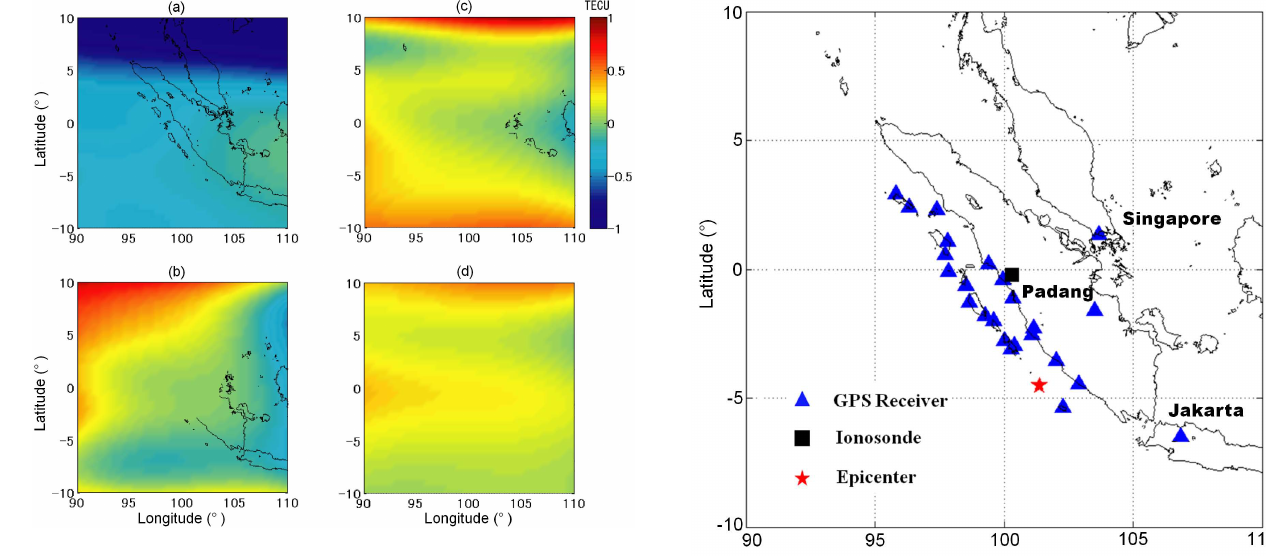
Fig. 3. Differences in the integrated electron content (IEC) between the original and the reconstructed data at 150km intervals from al- titudes of 100 to 700km. (a) IEC at altitudes of 100 to 250km, (b) IEC at altitudes of 250 to 400km, (c) IEC at altitudes of 400 to 550km altitudes, and (d) IEC at altitudes of 550 to 700km.